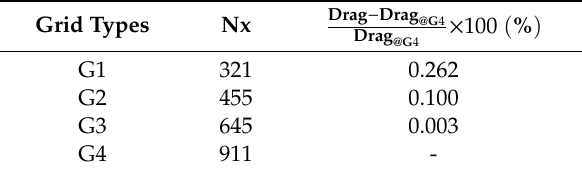
Table 2. Relative drag for the grid dependency test.